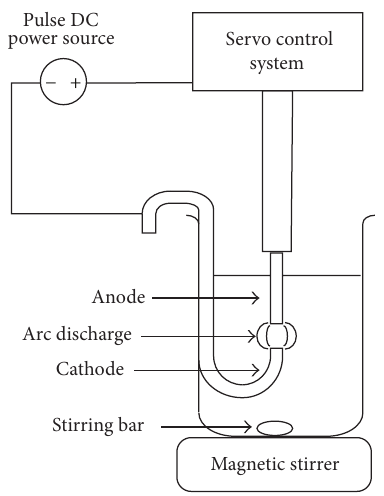
Figure 1: Schematic diagram of preparing nanofluids using the electrical discharge